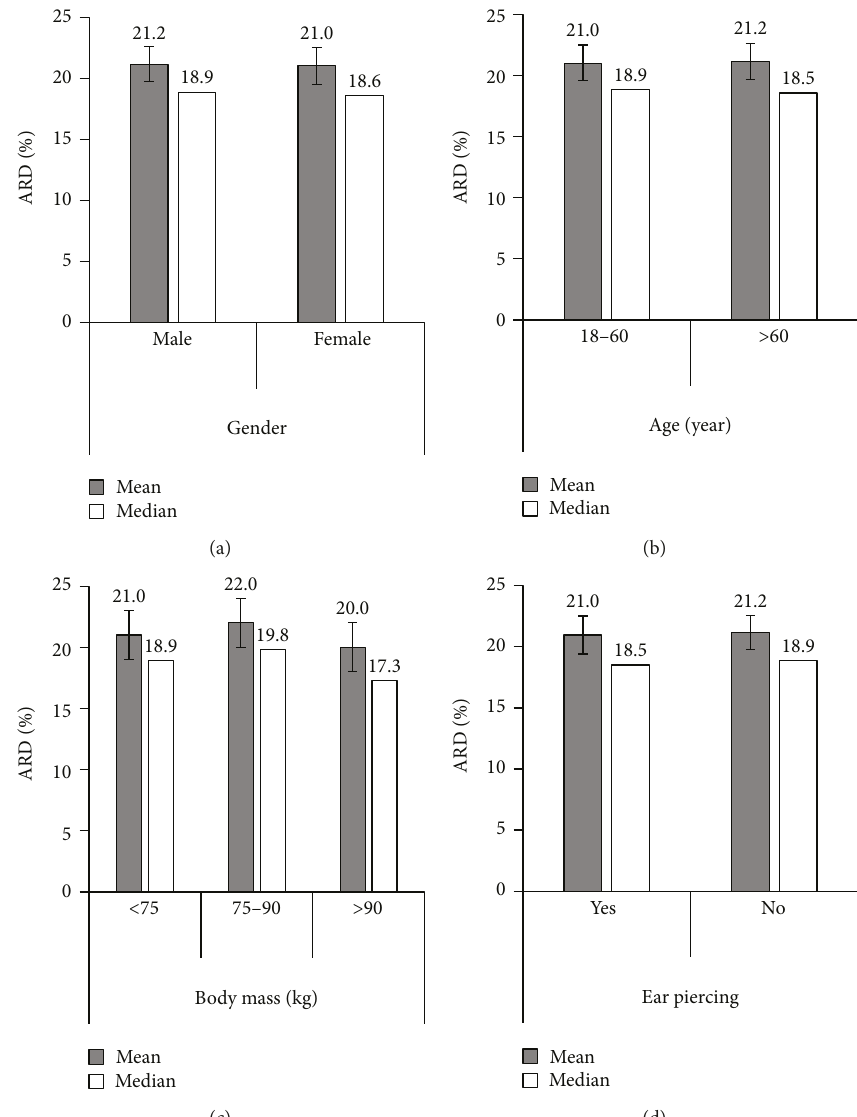
Figure 4: Numerical accuracy as a function of (a) gender, (b) age, (c) body mass, and (d) ear piercing. Mean ARD and its model-based upper and lower 95% con fi dence intervals and median